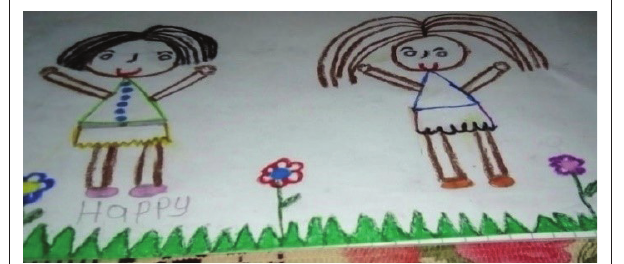
FIGURE 2: Child 2’ drawing.